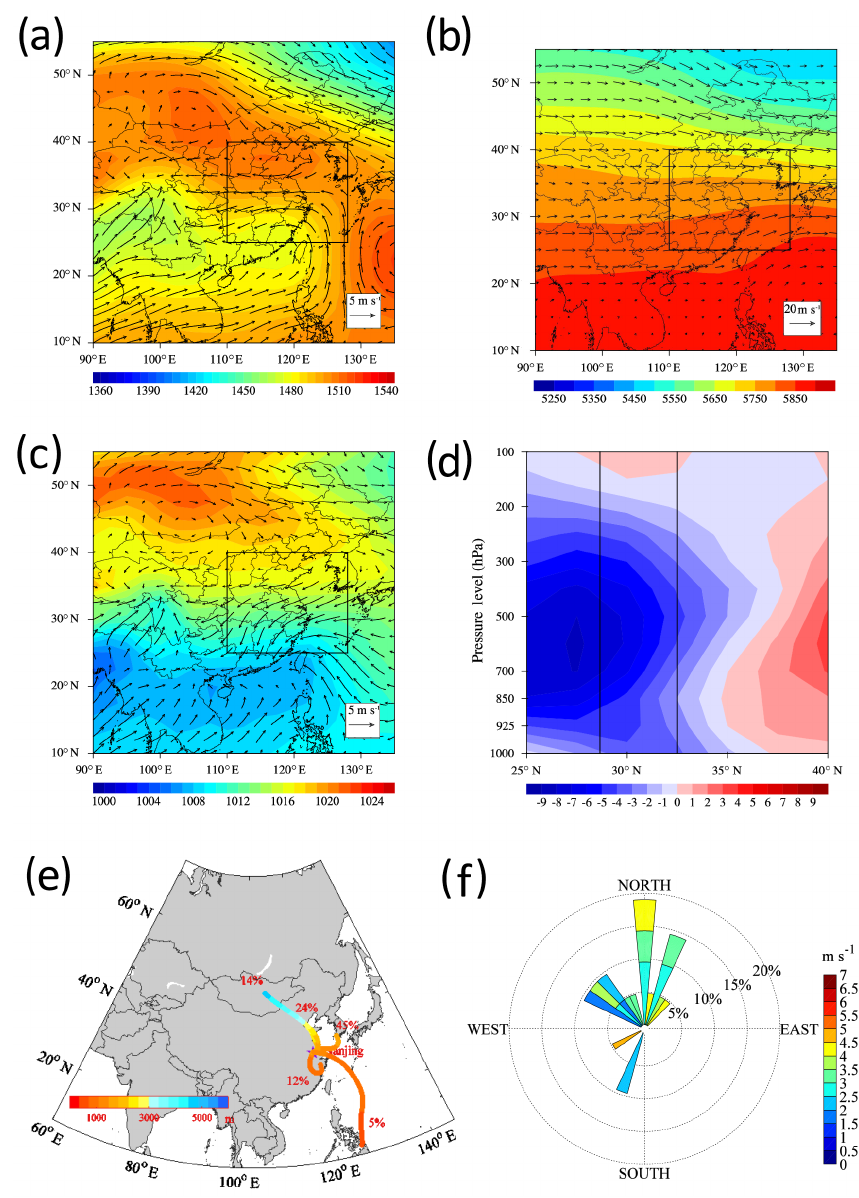
Figure 11. As in Fig. 7, but for Pattern